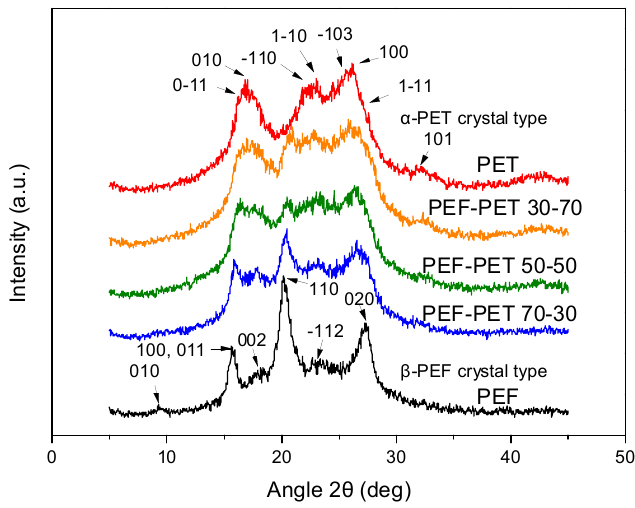
Figure 2. XRD patterns of poly(ethylene furanoate) (PEF), poly(ethylene terephthalate) (PET) and their blends.